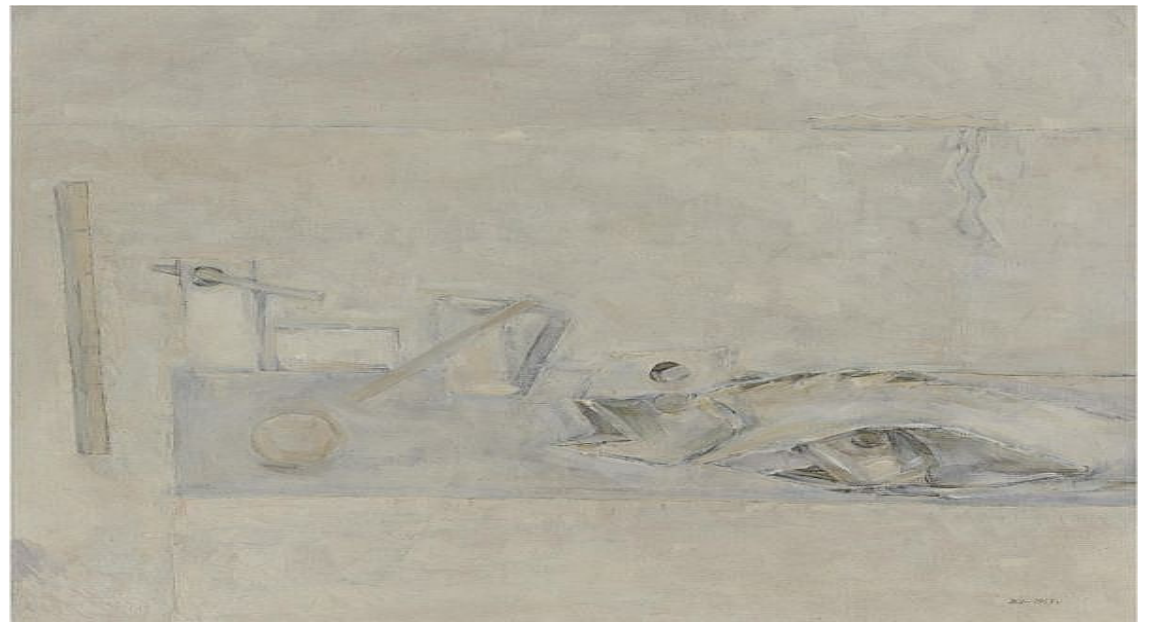
Figure 1. Eduard Steinberg. A Composition with Fish. Oils on canvas, 1967. 100 × 100. Private collection, USA. https://artinvestment.ru/auctions/2244/records.html?work_id=850820 (accessed on 16 May 2022).